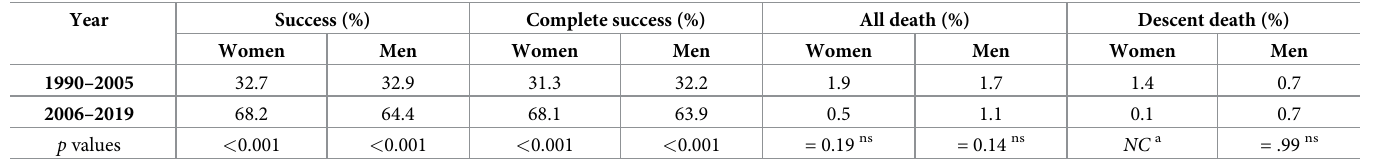
Fig 1. Rates of success (summited), complete success (summited and survived), overall death, and death descending from the summit. Rates are dodged to facilitate comparisons. https://doi.org/10.1371/journal.pone.0236919.g001 Sex and success rates In our prior analysis [11], women and men had nearly identical rates of success and of com- plete success. That patterns holds for the recent census (Table 2) and is further supported by a two sided). Table 2. Rates of success, complete success, and death (as percentage) on Everest for the recent two time